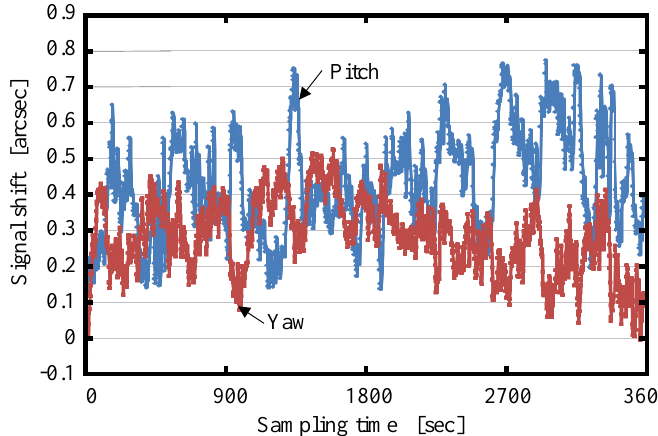
Figure 6. Stability of output signals of the miniature autocollimator